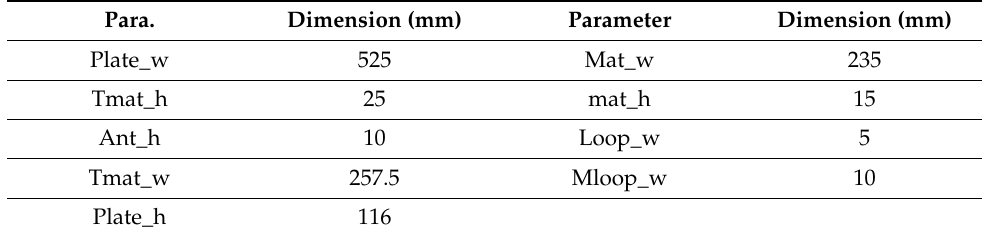
Table 1. Optimized parameter values.